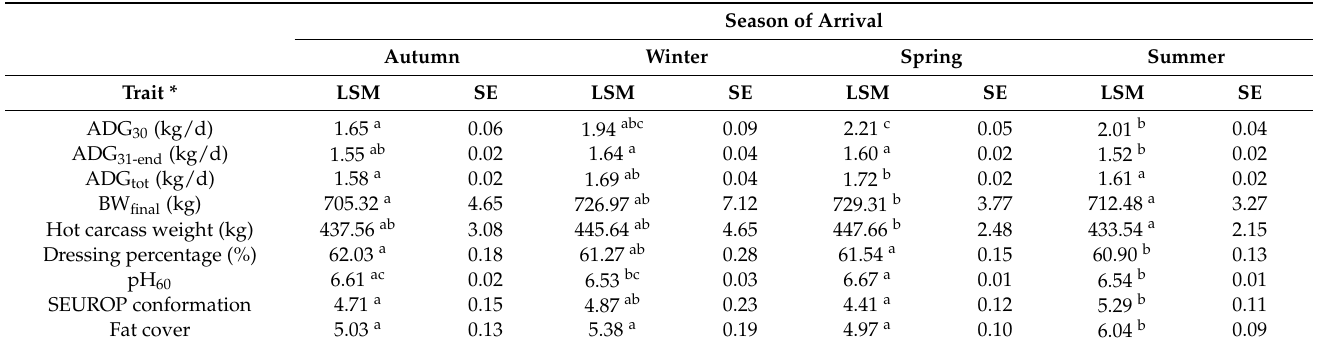
Table 3. Least squares means (LSM) and standard error (SE) of growth and post-mortem performances 1 of Charolaise young bulls ( n = 575) for season of arrival